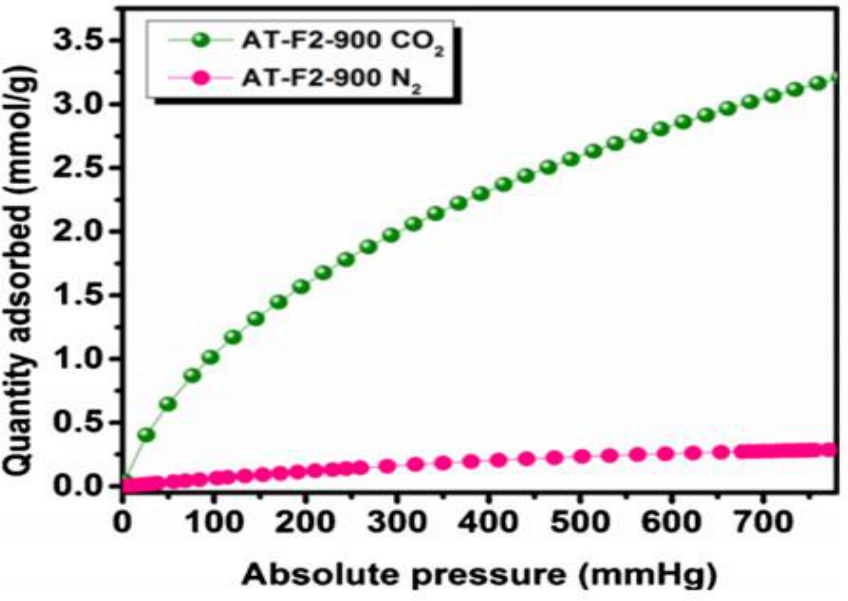
Figure 45. CO 2 and N 2 adsorption by benzoxazines at 25 °C (reproduced from the work in [109] with permission).